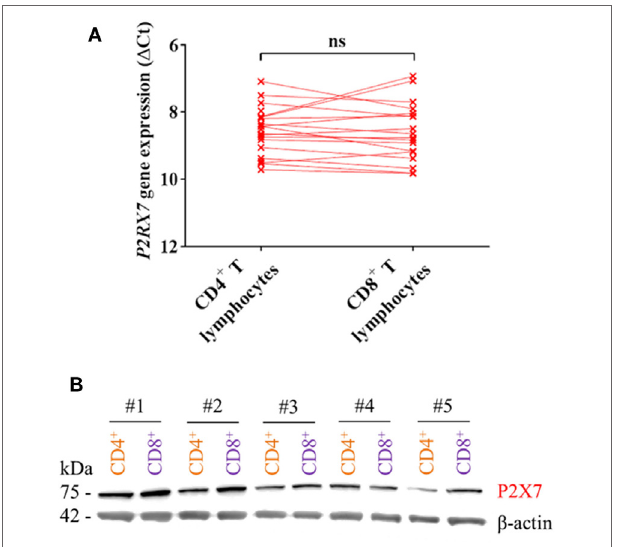
FigUre 2 | P2X7 levels are equally high in CD4 + and CD8 + T lymphocytes. (a) P2RX7 gene expression in human CD4 + and CD8 + T lymphocytes shown as Δ Ct values normalized to the genes for GAPDH and ACTB ( β -actin) from 18 to 21 independent donors. (b) Western blot showing P2X7 receptor signal (75 kDa) from protein lysate of CD4 + (orange) and CD8 + (purple) T lymphocytes from five different donors (#1–5). Loading control was β -actin (42